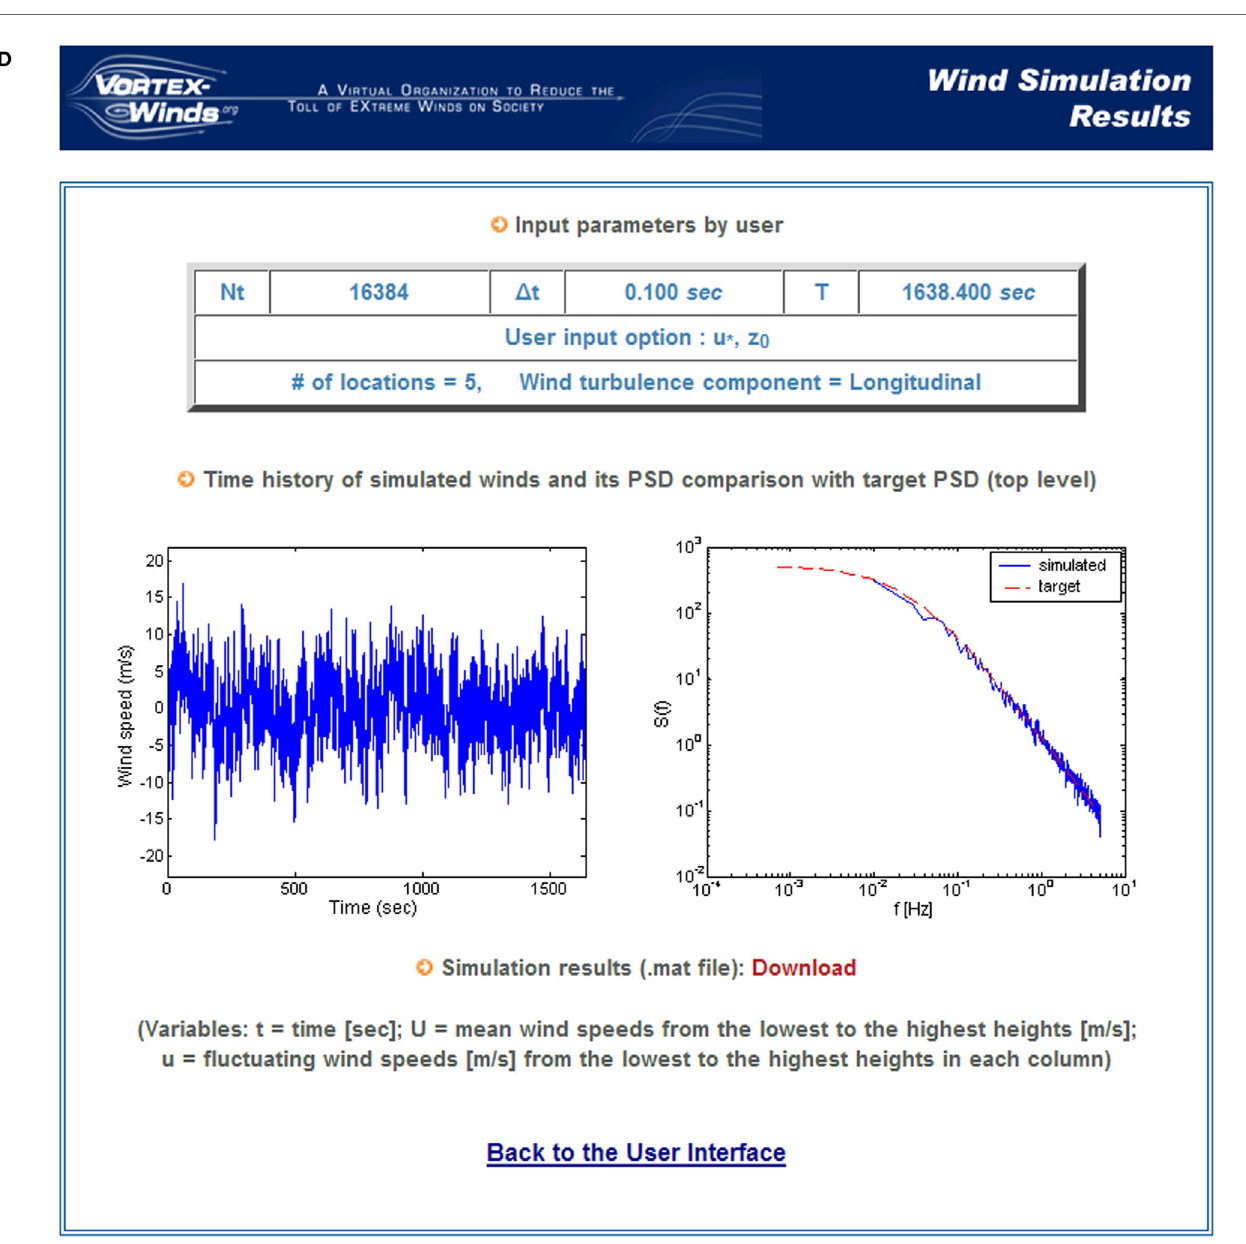
FigUre 9 | (a) User and (B) result interfaces of NatHaz on-line wind simulator (NOWS); (c) User and (D) result interfaces of VORTEX-Winds on-line wind simulator